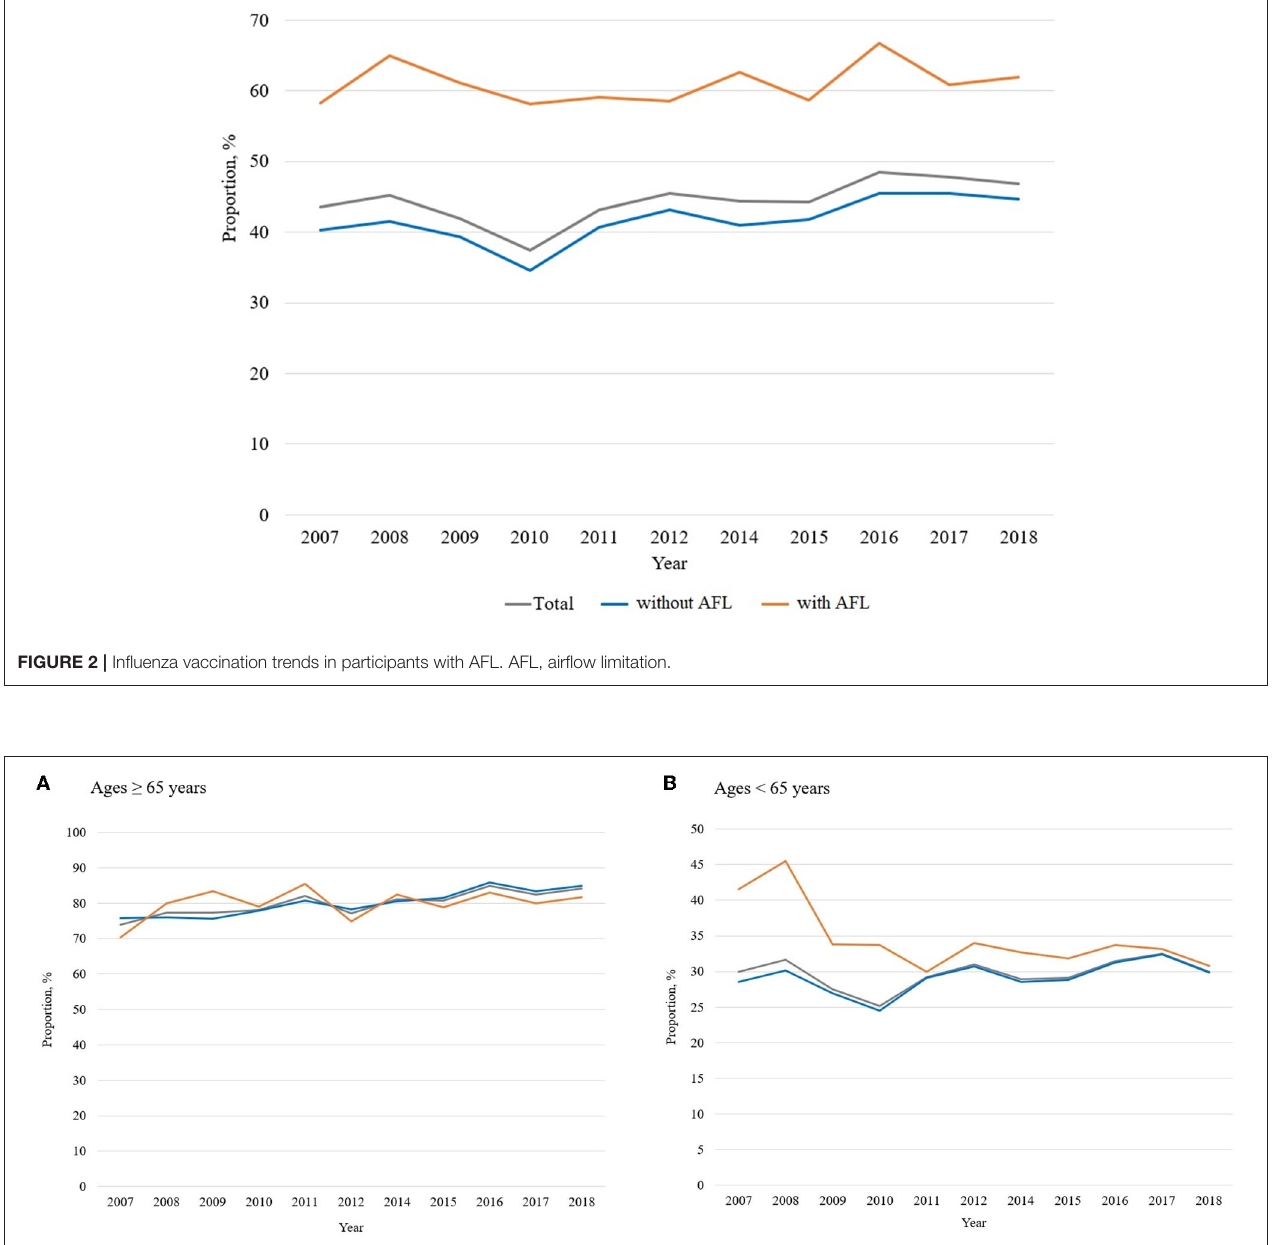
% predicted, vaccinated participants had lower lung function parameters [FEV 1 (L), FVC (L), FVC % pred, and FEV 1 /FVC] compared with unvaccinated participants ( p < 0.001 for the latter four variables).